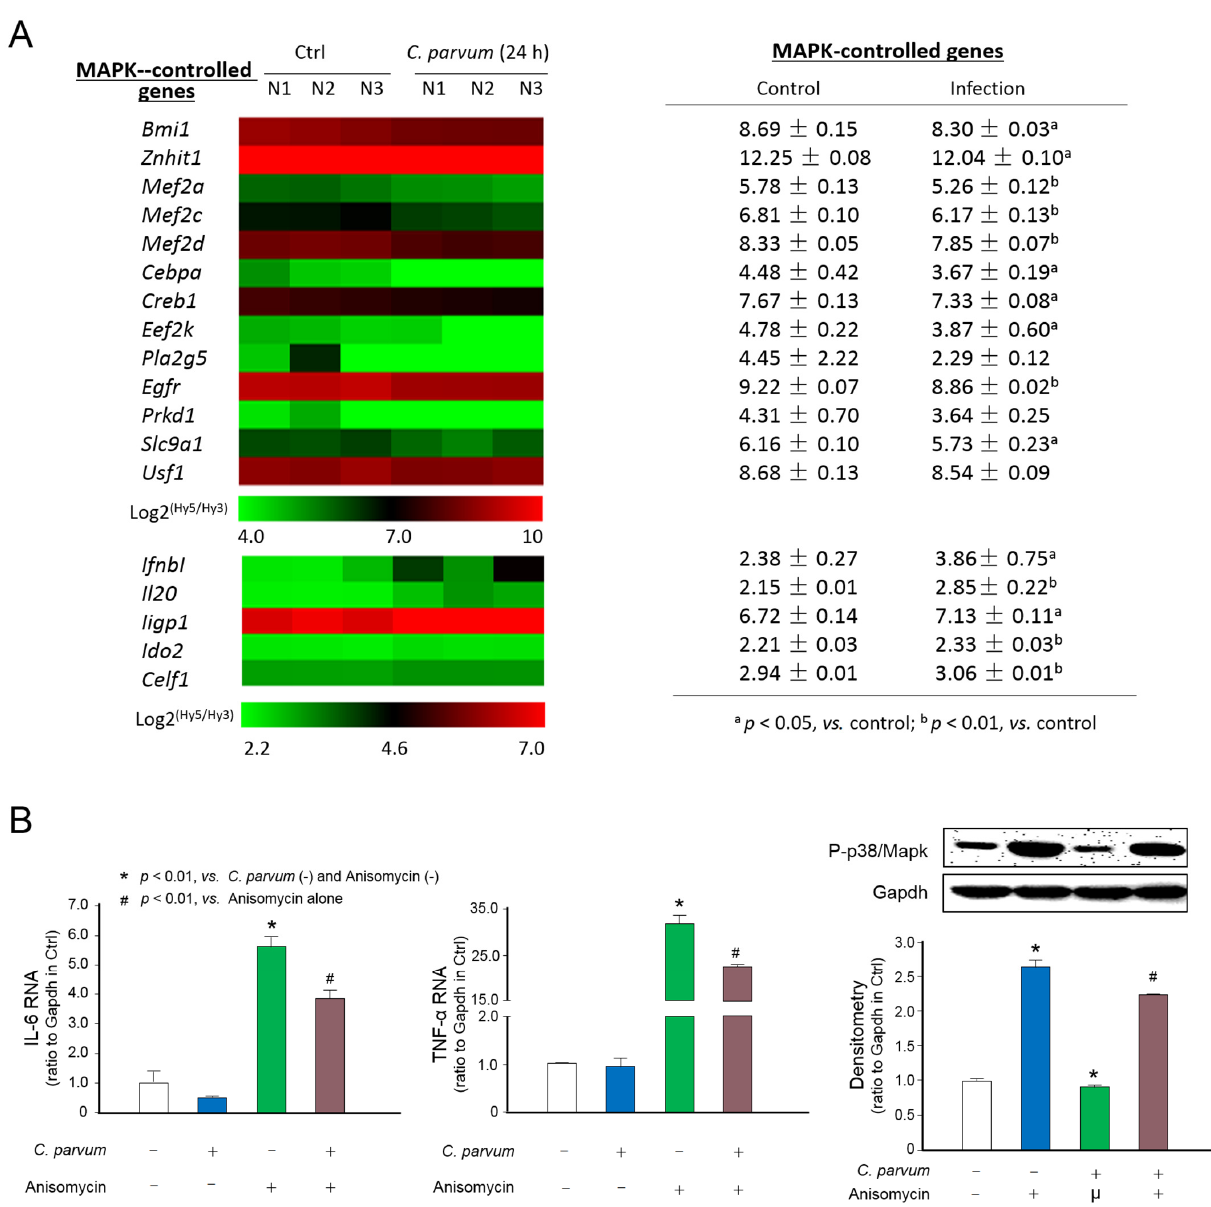
Figure 1. Suppression of MAPK signaling in intestinal epithelium following C. parvum infection. ( A ) Heatmap of expression levels of MAPK-controlled genes in host cells following C. parvum infection. IEC4.1 cells were exposed to C. parvum infection for 24 h. Total RNA was isolated for genome-wide transcriptome analysis via microarray. Expression levels of MAPK-controlled genes and selected inflammatory genes not directly related to the MAPK signaling are presented as the log2 (Hy5/Hy3), which passed the filtering criteria variation across the samples ( n = 3). a p < 0.05, vs., control; b p < 0.01, vs. control. ( B ) Suppression of Il-6 and Tnf- α expression and inhibition of phosphorylation of p38/Mapk in C. parvum -infected intestinal epithelial cells in response to MAPK activator stimulation. IEC4.1 cells were exposed to C. parvum infection